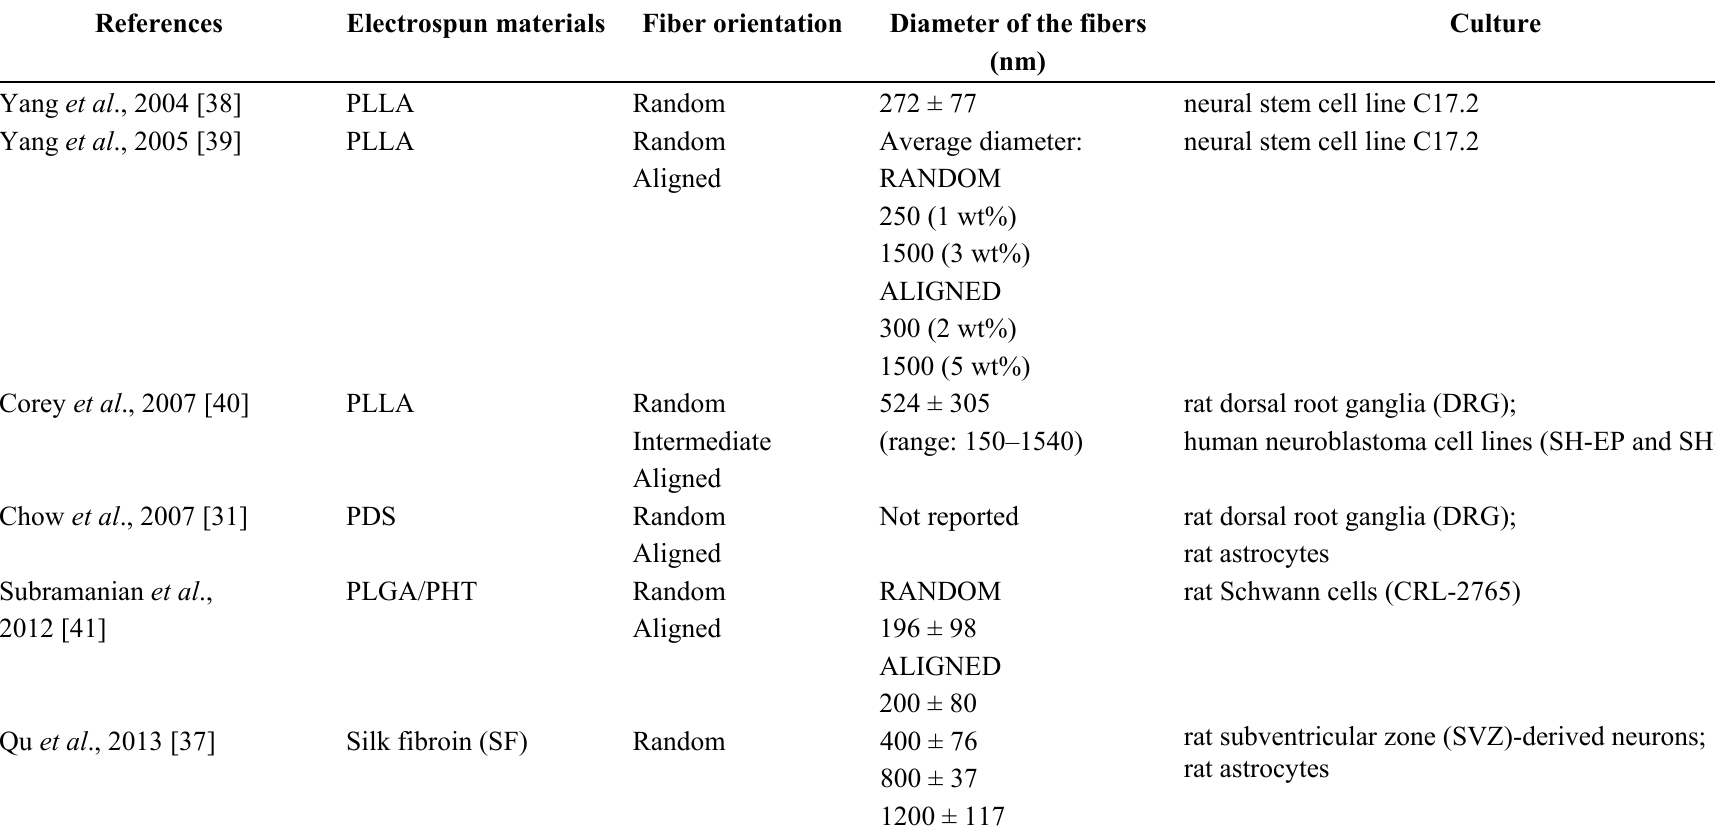
Table 2. Main features of the electrospun materials used in in vitro